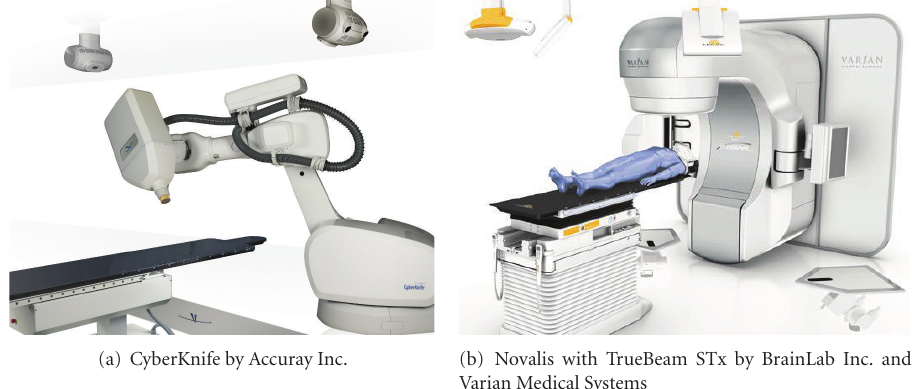
Figure 5: Radiosurgery robots use X-ray images taken during the treatment to control robotic patient tables, ensuring accurate targeting of the radiosurgery beams. The Cyberknife image and any Accuray trademarks or logos are used with permission from Accuray Incorporated. The image of the Novalis with TrueBeam STx is ©2012 BrianLab